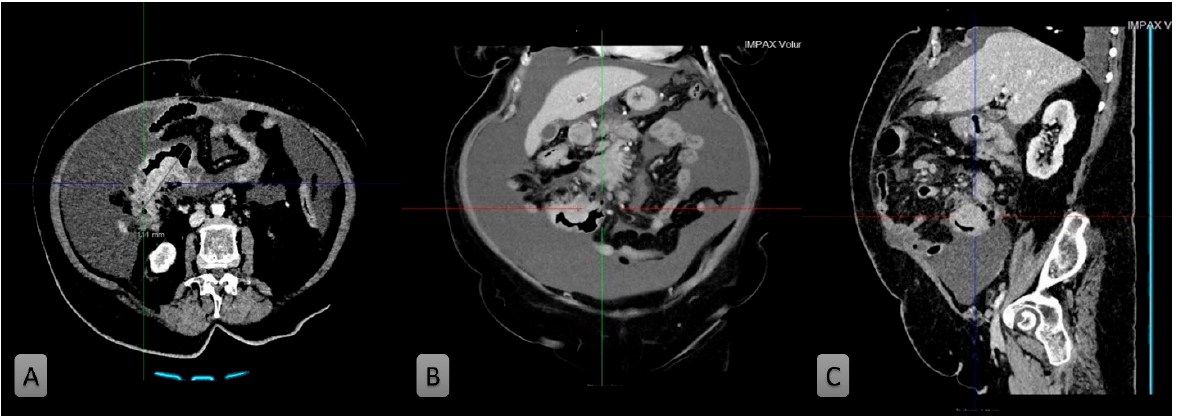
Figure 1. The tumor mass infiltrated all layers of the ileum wall ( A ). The vegetative mass about 3 cm in dimeter on the upper ileum wall ( B ). On all three images, ascites is present ( C ). The patient had an emergent laparotomy. Macroscopic finding showed ileum infil- Ascites is evacuated and cytological analysis of ascites showed the presence of atypical ration with vegetative mass (Figure 2). Ileocolic resection and latero-lateral ileocolic anas- tomosis was done. The microscopy findings of the terminal ileum and the regional lymph